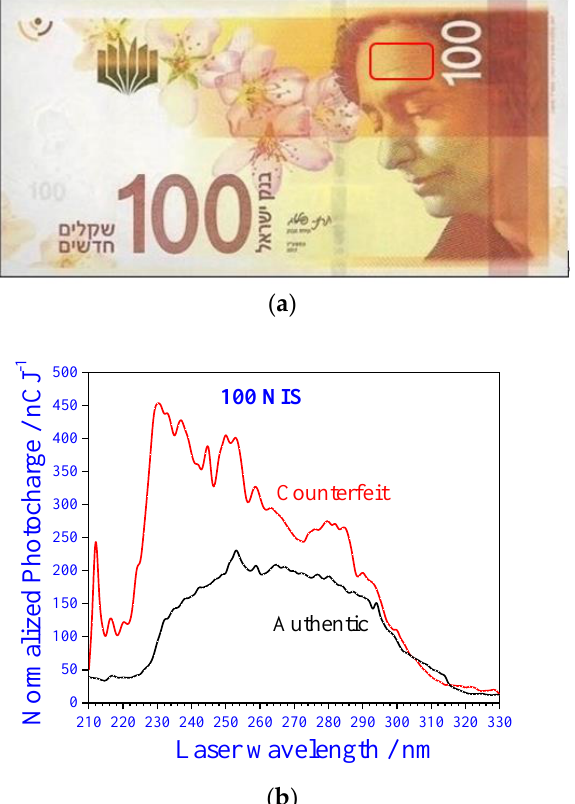
Figure 7. ( a ) The sampling location on a 100 NIS bill; MEES spectra of authentic and counterfeit 100 NIS banknotes; ( b ) MEES spectra of authentic and counterfeit 100 NIS banknotes.